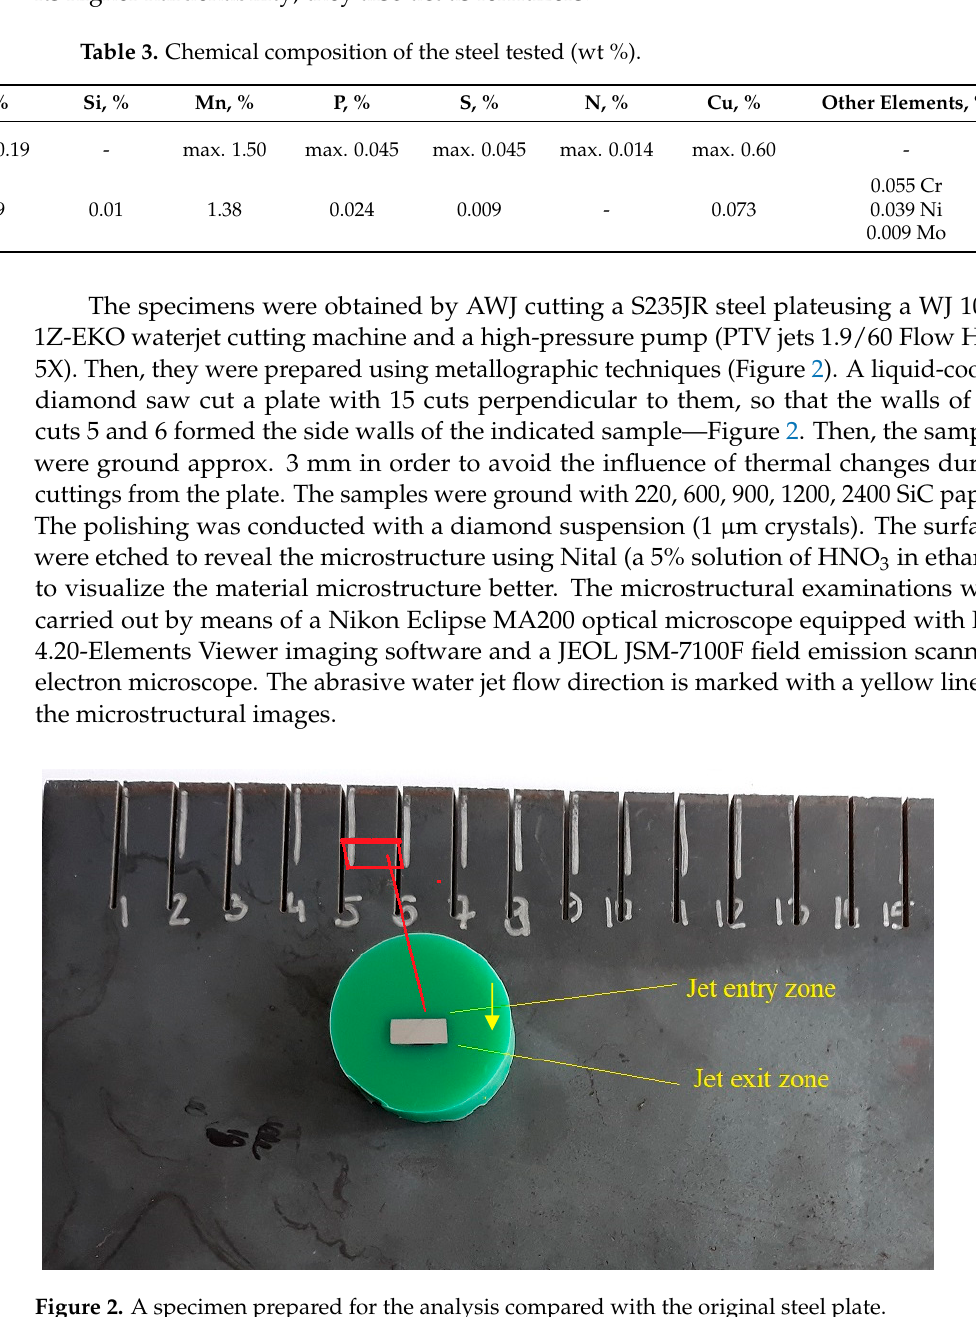
Figure 3. Microstructure of the uncut steel (the hot rolled steel). The surface layer of the uncut steel was characterized by considerable refinement of the microstructure, which was caused by significant plastic deformation accompanied by an increase in temperature. Figure 3 shows the microstructure of the S235JR steel after rolling. The areas in red rectangles are enlarged on the right. The bottom magnification presents considerable refinement of the microstructure, which was caused by significant plastic deformation accompanied by an increase in temperature. This fine-grained mi- crostructure was observed to a depth of about 40–60 µm from the line of rolling. The top magnification is our reference; it is an indication of the base material. As can be seen from